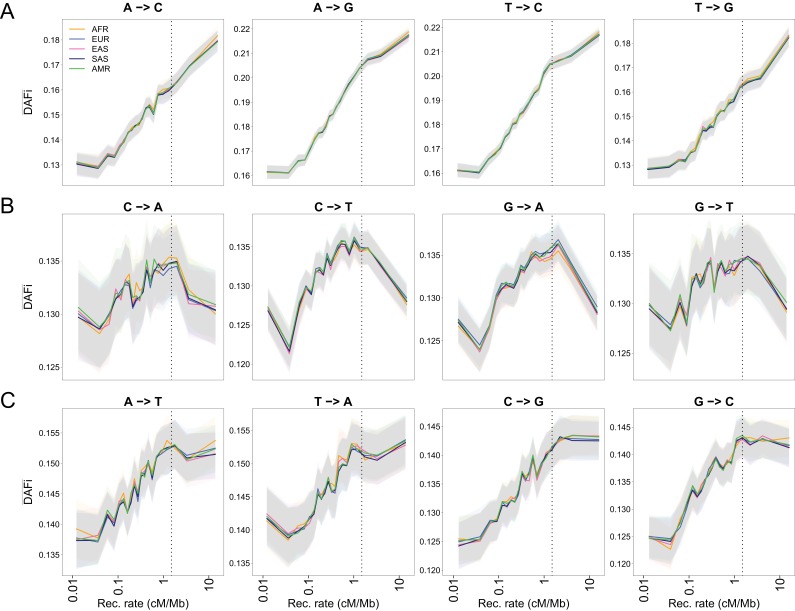
DAFi¯ as a function of recombination rate for different mutation types in 1000G individuals.The figure is a decomposition of Figure 1C for all possible substitutions. (A) WS mutations. (B) SW mutations. (C) WW and SS mutations. Note that WW and SS sites should only be affected by BGS and not by gBGC. Dashed vertical lines show the approximate limit of the influence of BGS (1.5 cM/Mb), above which DAFi¯reaches a plateau for sites unaffected by gBGC. Shaded areas correspond to 95% CI obtained by a block-bootstrap approach (see Materials and methods).